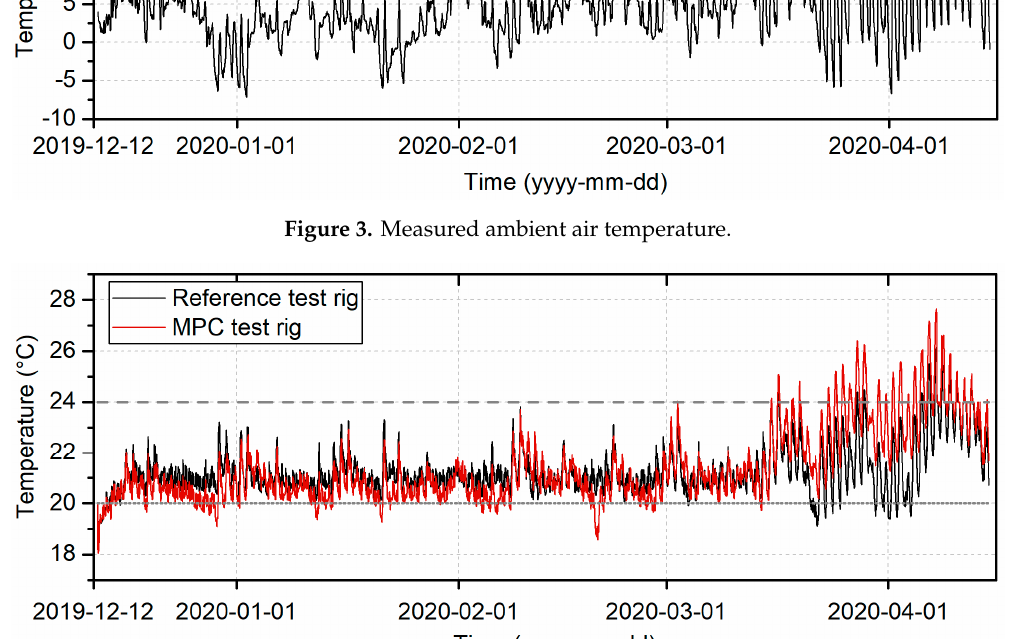
Figure 4. Building zone temperatures and thermal comfort limits.